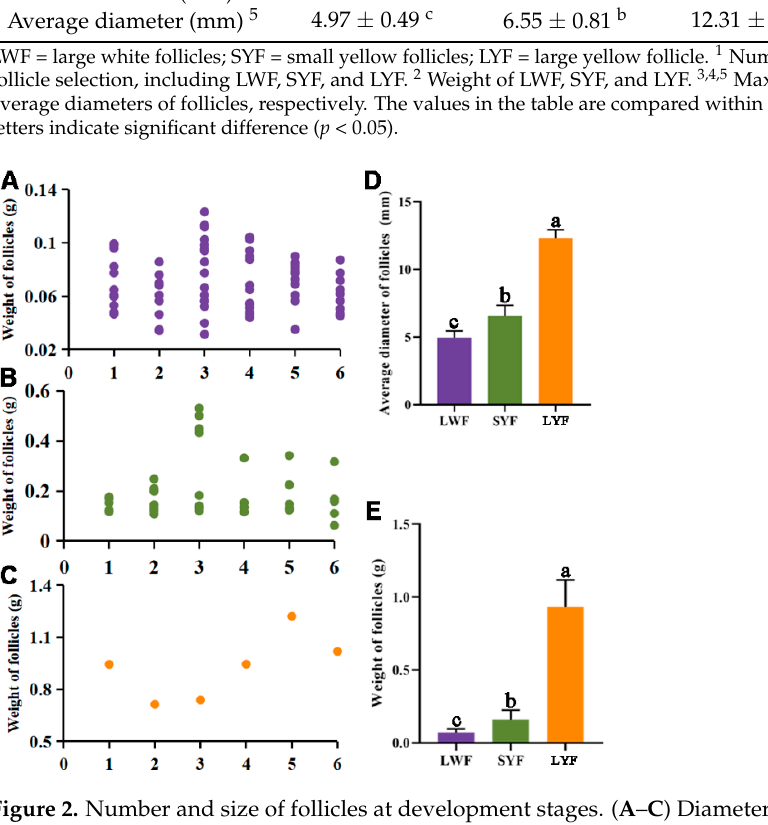
Figure 2. Number and size of follicles at development stages. ( A – C ) Diameter and weight of large white follicles (LWF) ( A ), small yellow follicles (SYF) ( B ), and large yellow follicles (LYF) ( C ). Each number on the x -axis represents an individual hen, and each dot represents one follicle. ( D , E ) Average diameter ( D ) and weight ( E ) of follicles around follicle selection. Data represent the mean ± standard error ( n = 6), and different letters indicate significant difference ( p < 0.05).